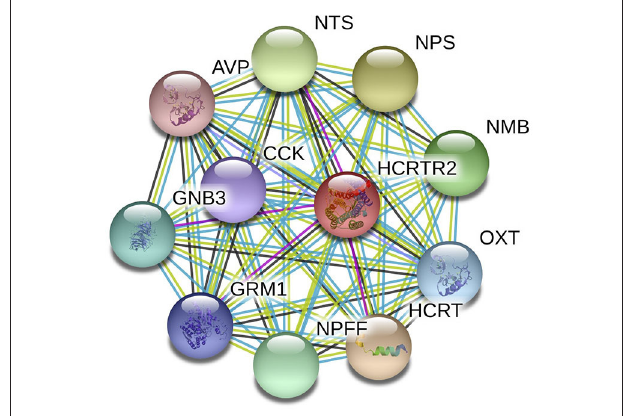
FIGURE 1 | PPI network of HCRTC2 and its closest functional partners.